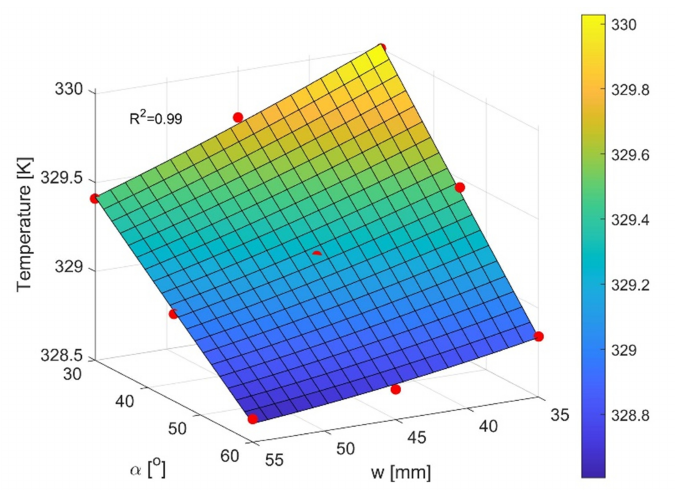
Figure 16. Temperature dependence behind the heat sink depending on fin shape.